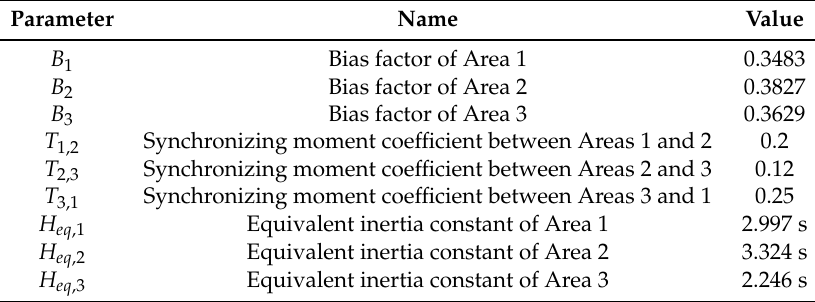
Table 5. Interconnected three-area power system parameters [30].